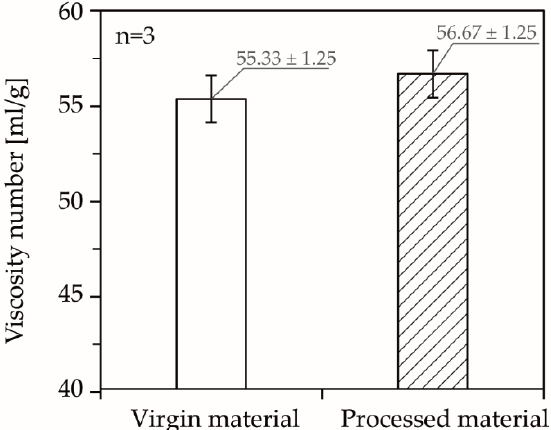
Figure 8. Comparison of the viscosity number of the processed material compared to the virgin material.